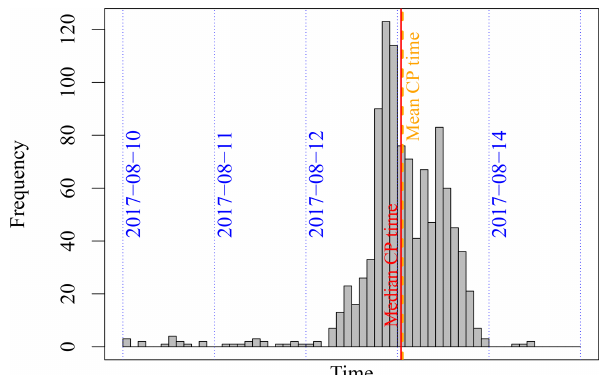
Figure 10. Histogram of closest pass times of trajectories to the PNE. The median and mean values are marked in red and orange respectively. The dotted blue lines are at 00:00UTC.